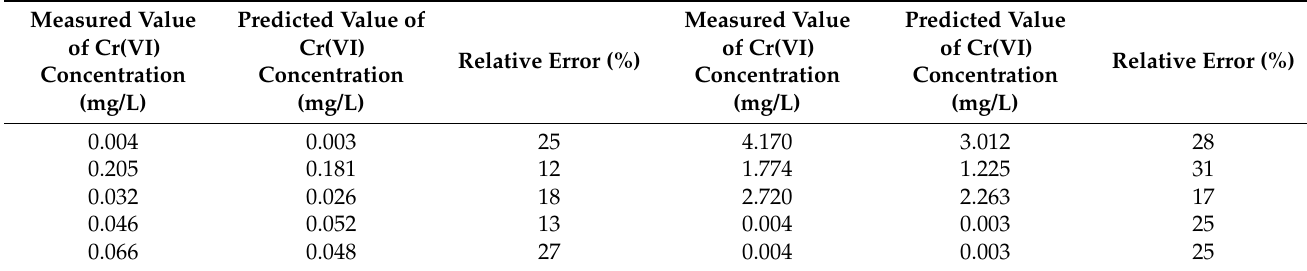
Table 2. Comparison of simulation and measured